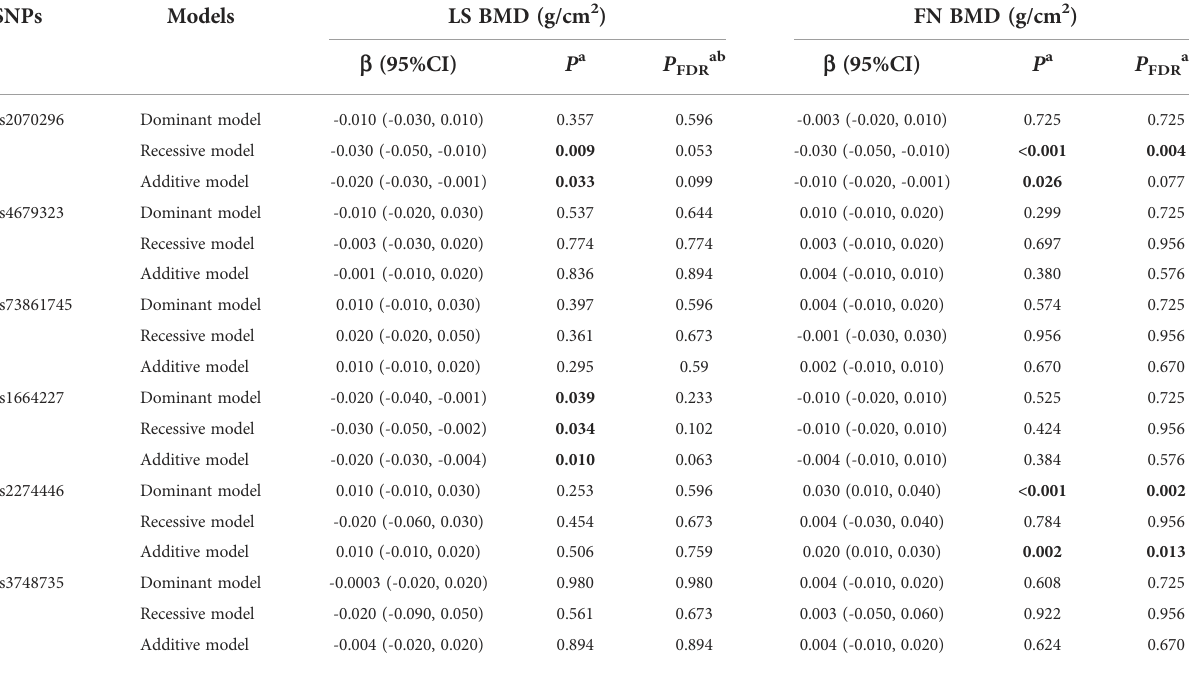
TABLE 5 Multivariate linear regression results of associations between common genetic variants and BMDs in the combination dataset analysis. SNPs Models